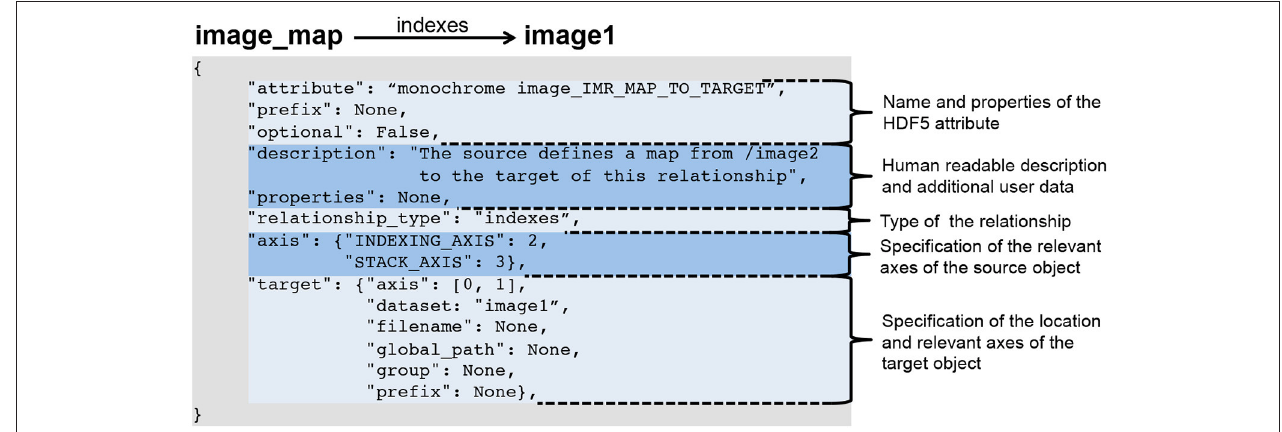
FIGURE 2 | Example specification of a relationship